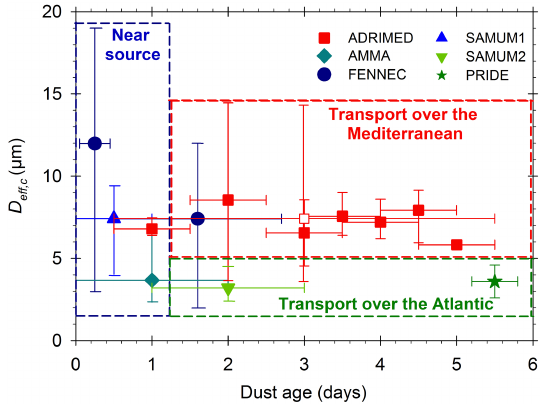
Figure 11. Effective diameter of the coarse mode D eff,c as a func- tion of the dust age observed during ADRIMED (squares). Filled red squares represent the average values observed for each dust age and the empty red square represents the campaign average value. Values are compared to those observed in dust source re- gion (in blue) during FENNEC (circles), SAMUM1 (triangle) and AMMA (diamond), as well as measurements in the Atlantic Ocean (in green) in the Cape Verde region during SAMUM-2 (triangle) and in Puerto Rico during PRIDE (stars). The horizontal error bars represent ± 0.5-day uncertainties on the dust age estimated using HYSPLIT and SEVIRI RGB images. The vertical error bars repre- sent the range of values obtained for each dust